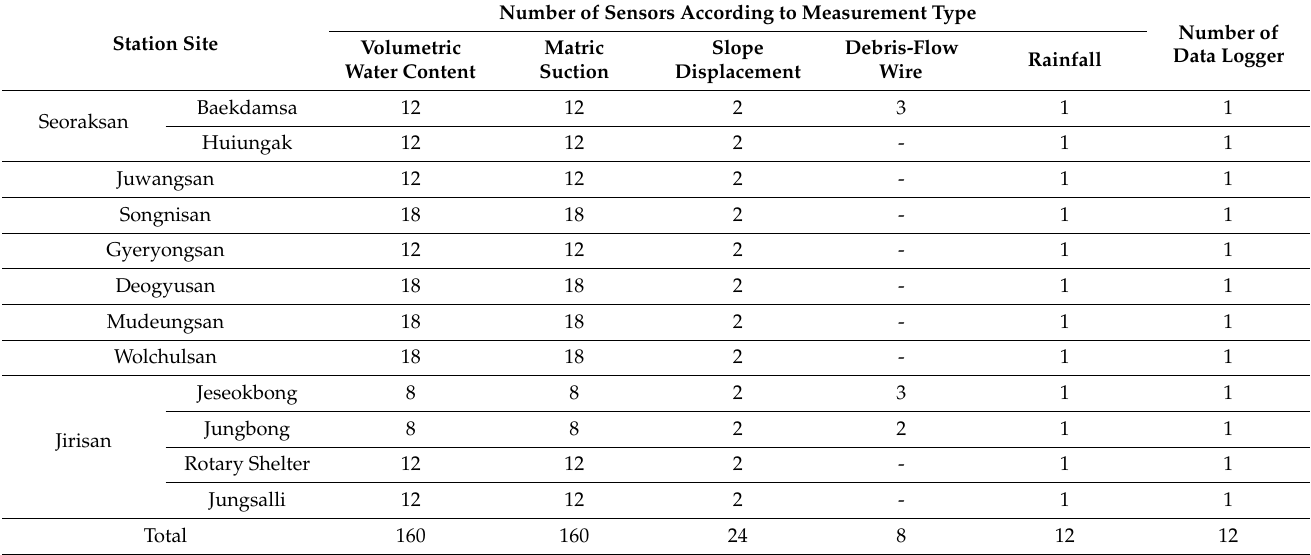
Table 4. Sensors installed in the landslide monitoring